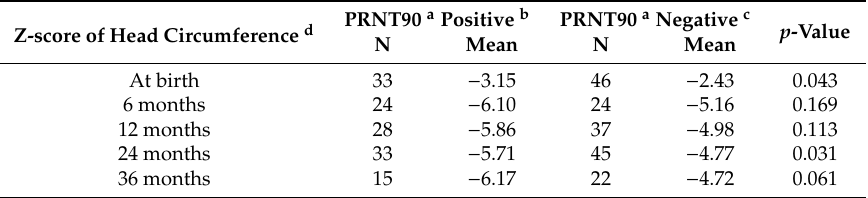
Table 4. Means of the Z scores of the head circumference at birth and at 6, 12, 24, and 36 months and positive and negative plaque reduction neutralization test in cases of CZS. S ã o Lu í s, Brazil, 2016–2018. PRNT90 a Positive b PRNT90 a Negative c Z-score of Head Circumference d